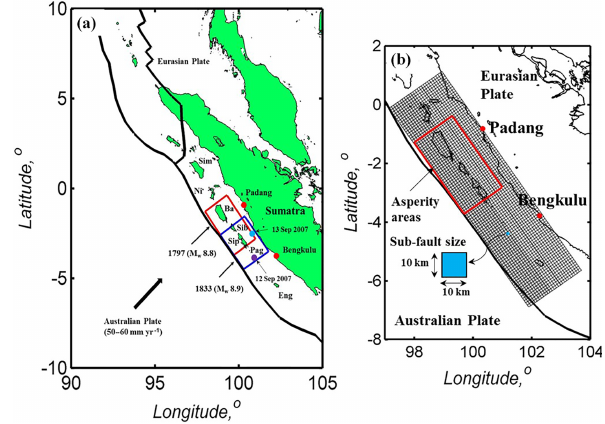
Figure 1. (a) Significant seismic events in the Mentawai segment of the Sunda subduction zone (Sim: Simeulue; Ni: Nias; Ba: Batu; Sib: Sibereut; Sip: Sipora; Pag: Pagai Islands; Eng: Enggano). (b) Fault plane of the Mentawai segment source along with the